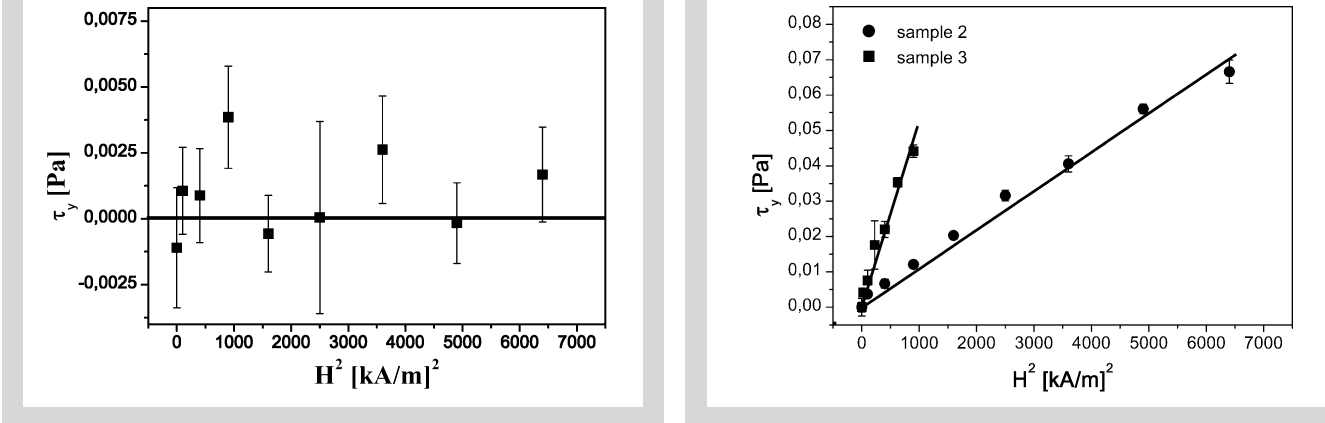
Figure 9: (a – left) Small particles (d = 10 nm) contained in sample 1 do not form structures. For this ferrofluid, a yield stress τ y could not be observed. (b – right) Yield stress τ for both fer- y rofluids depends quadrati- cally on the strength of the applied magnetic field. For the cobalt based ferrofluid (sample 3) with a higher λ * stronger effect is observed compared to magnetite based ferrofluid (sample